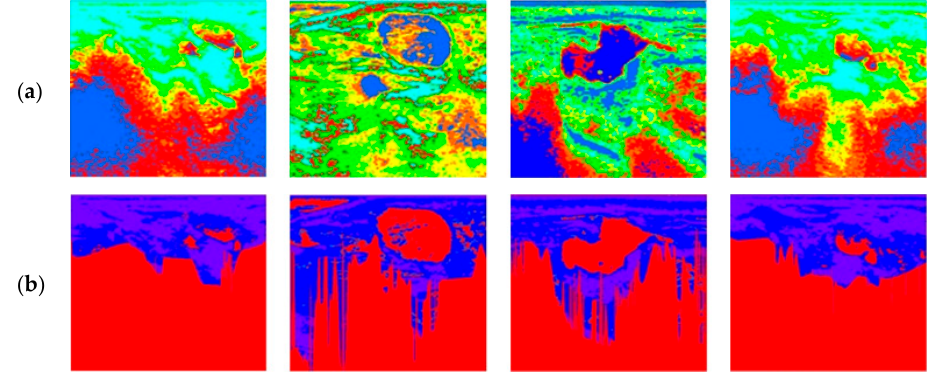
Figure 10. Comparison of quantization: ART2 in [24] vs. proposed FCM. ( a ) ART2, ( b ) FCM.